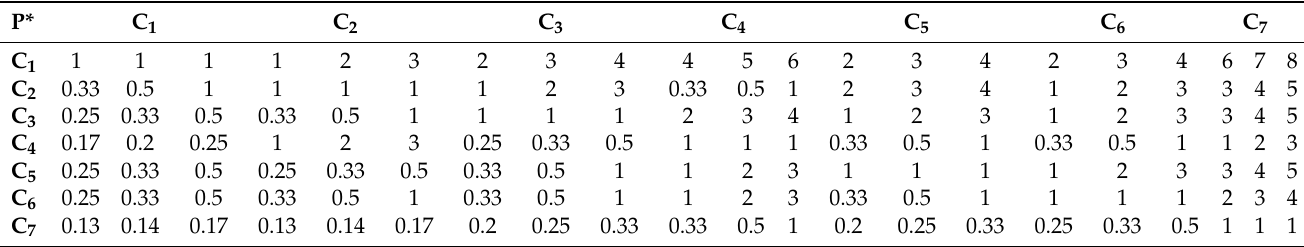
Table 5. The fuzzy pairwise comparison matrix determined for the Ridder–Sokolny mine.